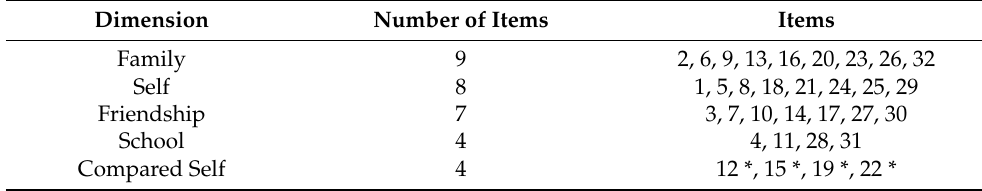
Table 1. Items of the dimensions of the MSSLC. Dimension